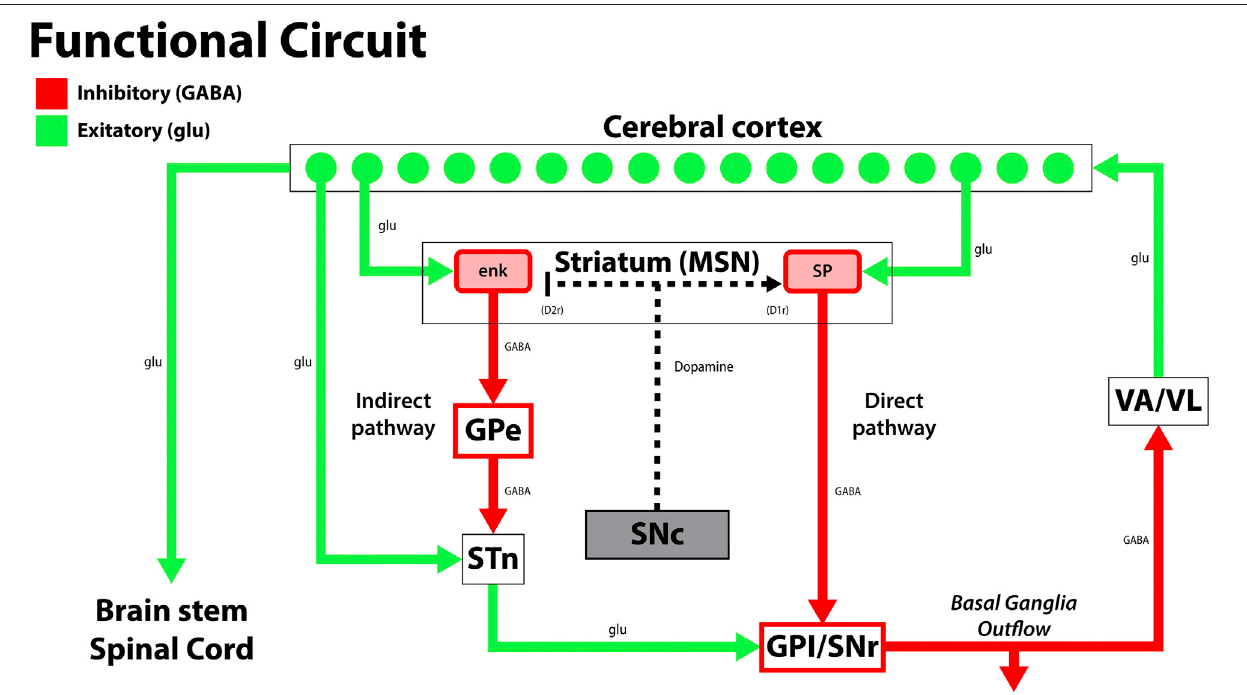
FIGURE 4 | A diagram of the classical and simpli fi ed functional circuit of the basal ganglia. Dopaminergic neurons from the substantia nigra pars compacta (SNc) project to the medium spiny neurons (MSNs) of the striatum and modulate the direct and indirect pathway activity to modulate inhibition by the thalamus (VA/VL). Green arrows signify glutamatergic excitatory neurons and red arrows signify GABA expressing inhibitory neurons. enk, enkephalin; SP, Substance P; GPe, globus pallidus, external segment; GPi, globus pallidus, internal segment; SNc, substantia nigra pars compacta; SNr, substantia nigra pars reticulata; STN, subthalamic nucleus; VA/VL, ventral anterior/ventral lateral nucleus of the thalamus; D1r, D1 dopaminergic Gs coupled receptor; D2r dopaminergic Gi coupled receptor. Adapted from (McGregor and Nelson, 2019).